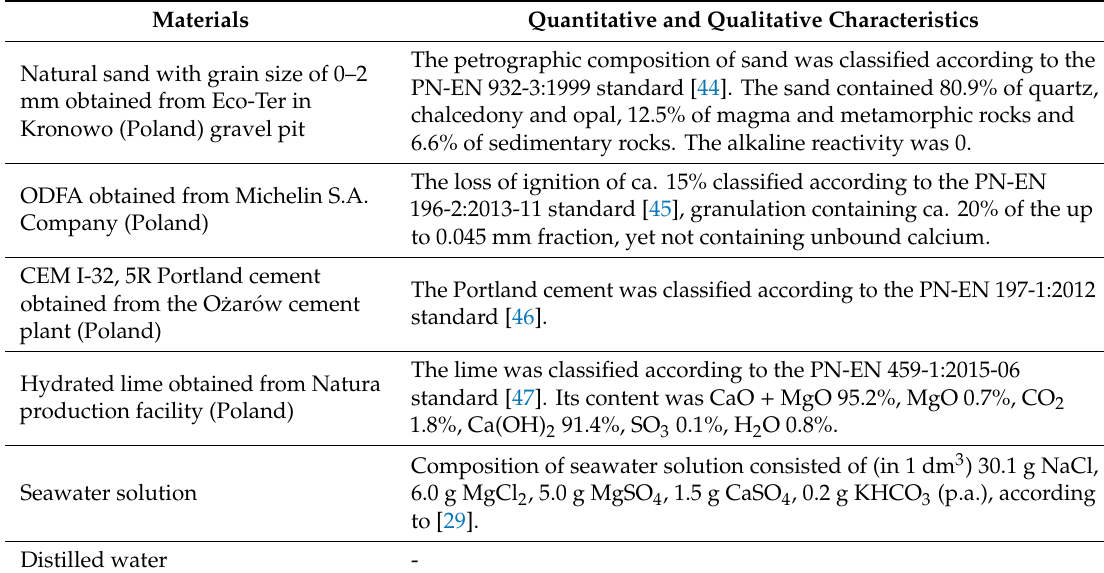
Table 1. Characteristics of the materials used in the research.